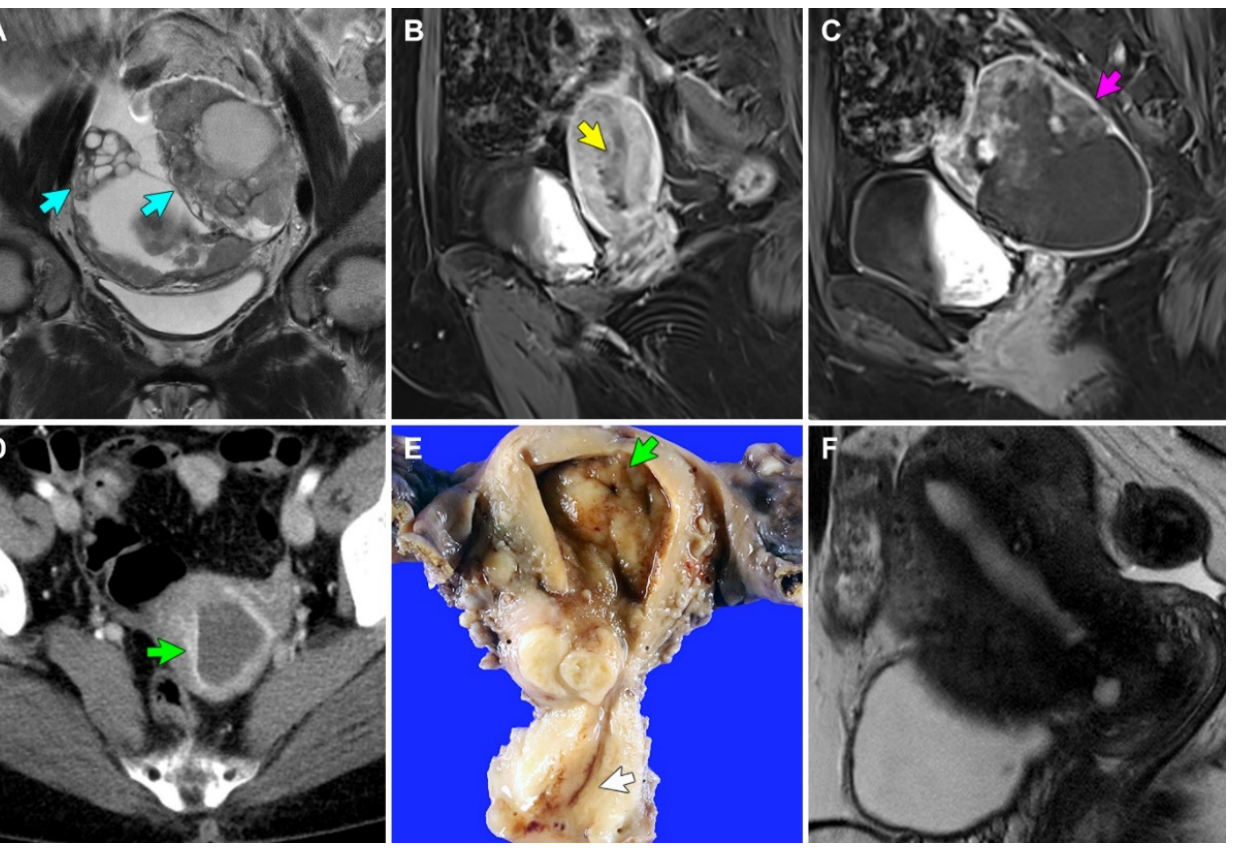
Figure 1. MRI, CT, and gross findings. ( A ) Case 1: T2-weighted coronal MR image reveals solid and cystic bilateral ovarian masses (blue arrows). ( B , C ) Case 2: T1-weighted Dixon sagittal MR images reveal ( B ) 3.4 cm endometrial mass (yellow arrow) and ( C ) 8.6 cm solid and cystic left ovarian mass (purple arrow). ( D ) Case 3: Contrast-enhanced CT image reveals a 1 cm endometrial mass